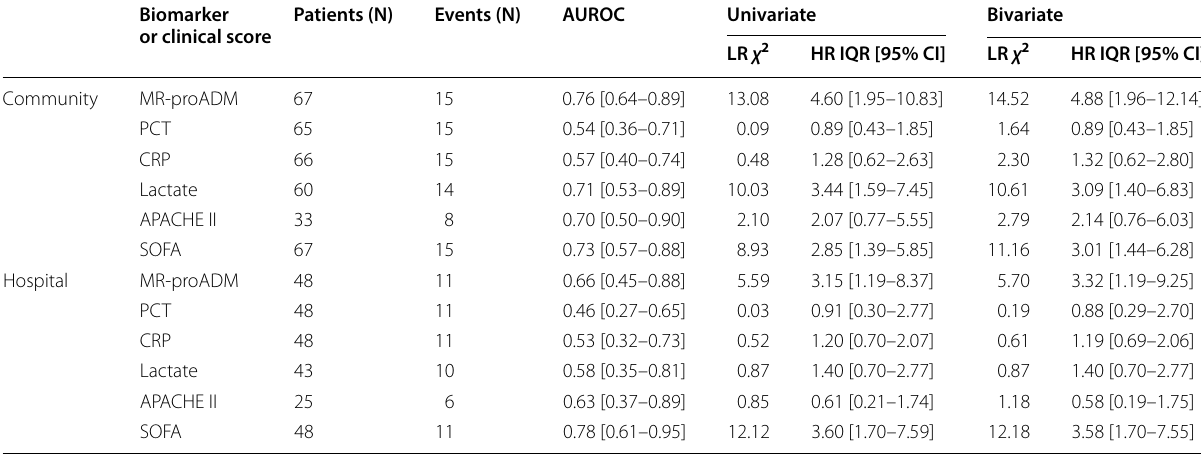
APACHE II Acute Physiological and Chronic Health Evaluation II score, AUROC area under the receiver operating characteristic curve, CI confidence interval, CRP C-reactive protein, HR hazard ratio, IQR interquartile range, LR likelihood ratio of the χ 2 test, MR - proADM mid-regional proadrenomedullin, N number, PCT procalcitonin, SOFA Sequential Organ Failure Assessment score